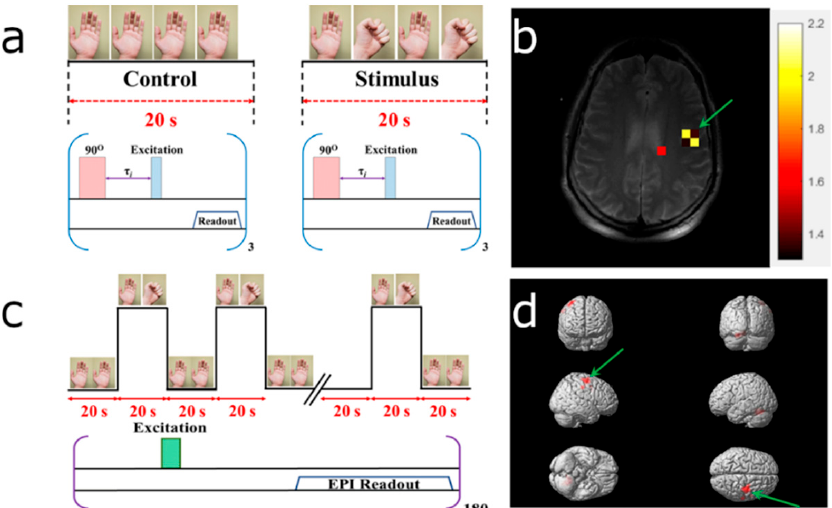
Figure 5. Detection of the hemodynamic response to a motor stimulus using HP 129 Xe perfusion mapping corroborated by blood oxygenation level-dependent (BOLD) functional brain MRI (fMRI). ( a ) Experimental design used for hemodynamic response detection. Two separate perfusion maps were acquired during the control (calm rest) and motor stimulation (left fist clenching) stages. ( b ) Hemodynamic response map created by subtracting the control perfusion map from the stimulated perfusion map and overlaid on top of the high-resolution proton scan. Activation of the right posterior precentral gyrus (i.e., the motor cortex) was observed. ( c ) BOLD fMRI experimental design for validation of the HP 129 Xe technique. ( d ) BOLD fMRI 3D activation maps. Activation was observed from the motor cortex (green arrow); this result correlated with the HP 129 Xe hemodynamic response map.